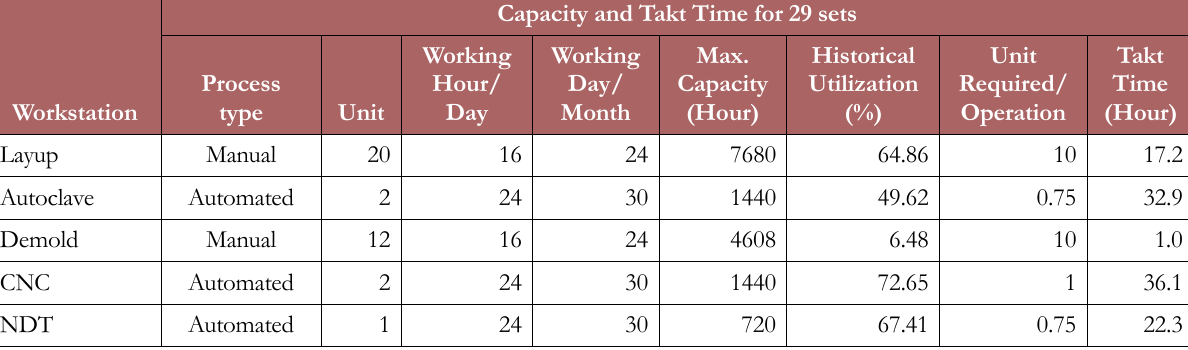
Table 9. Capacity available and Takt time of each workstation